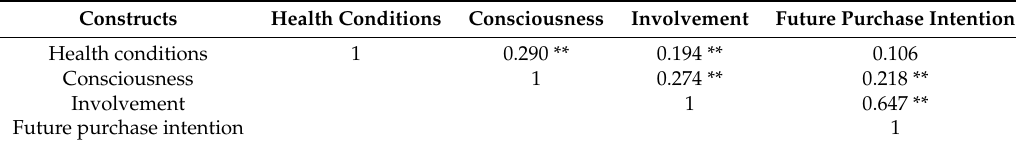
Table 4. Relationshipbetweenhealthconditions,consciousness,involvementandfuturebehavioralintention. Constructs